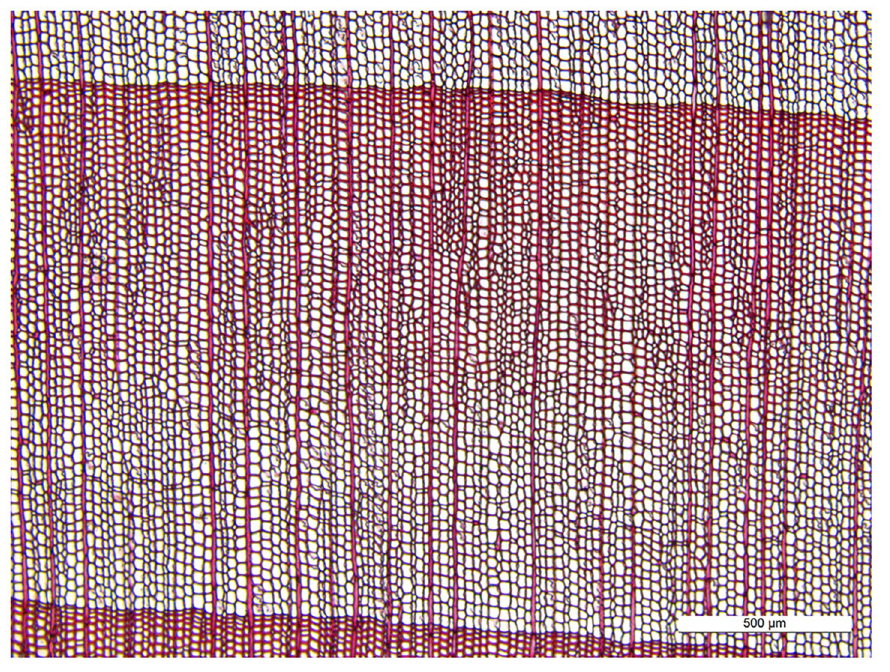
Fig 2. Cross-section of Podocarpus neriifolius